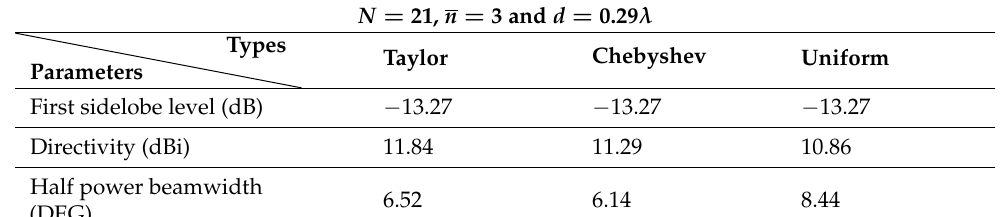
Table 1. Parameters of a n Taylor-like super-directive pattern.